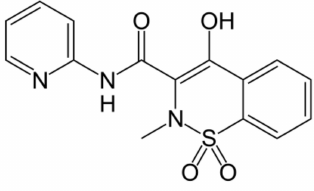
Scheme 1. Chemical structure of the piroxicam drug